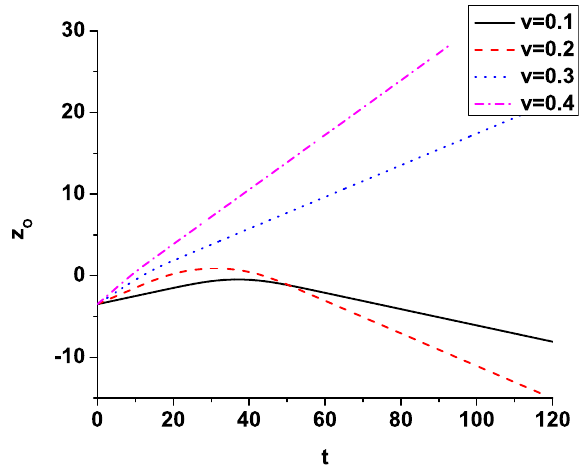
Figure 6 . The path of the object in the collision process with the wall as a function of its velocity. On the y-axis we have z O , which represents the location of the center of the object at some moment in time. The parameters are chosen to be A = 5 × 10 − 4 , m = 1 , R = 1 . 5 , while the initial values for initial v O are marked in the plot. For low velocities the object cannot cross the wall. For high enough velocities the object has enough energy to pass through the